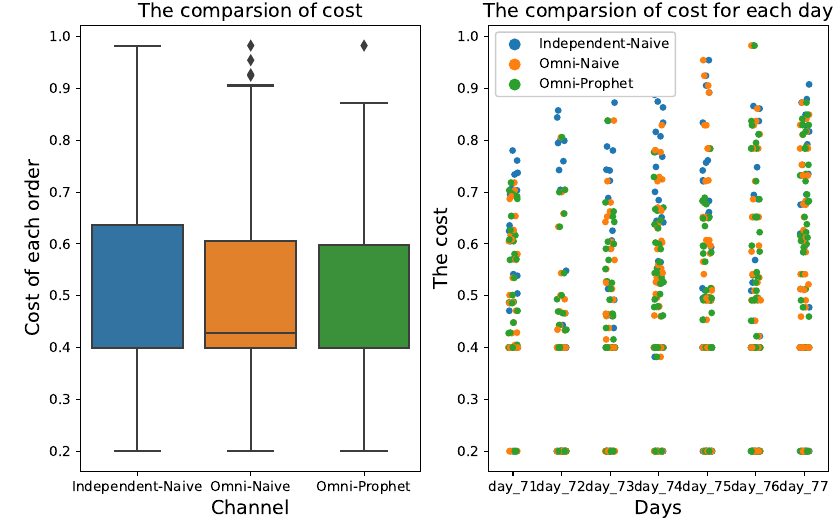
Figure 7. Results of the cost comparison.